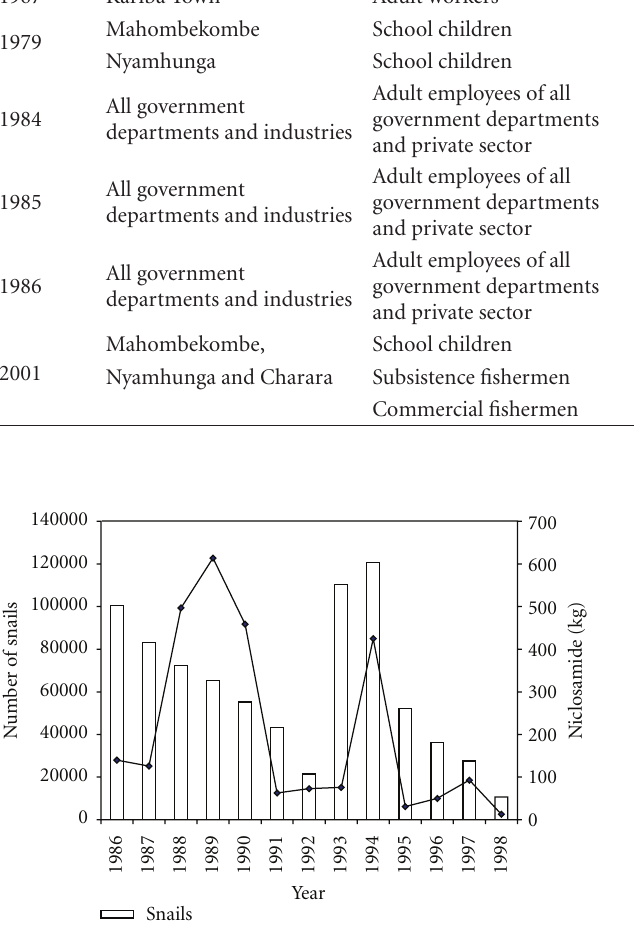
Figure 3: Snail population densities and quantities of niclosamide applied to reduce the snail numbers from 1986 to 1998 [9].